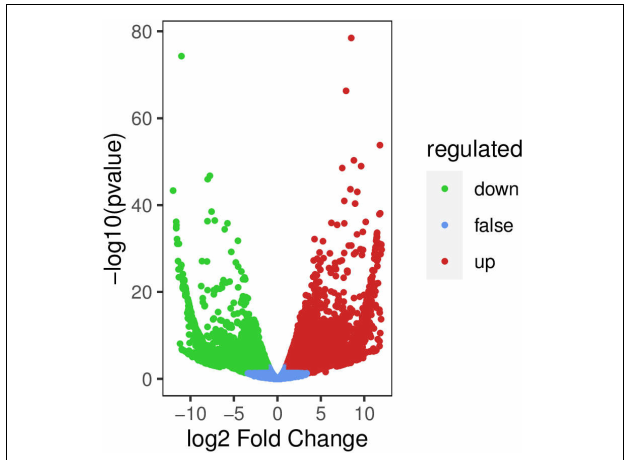
FIGURE 9 | Volcano map of differential genes between Qssg and Lc fruits.